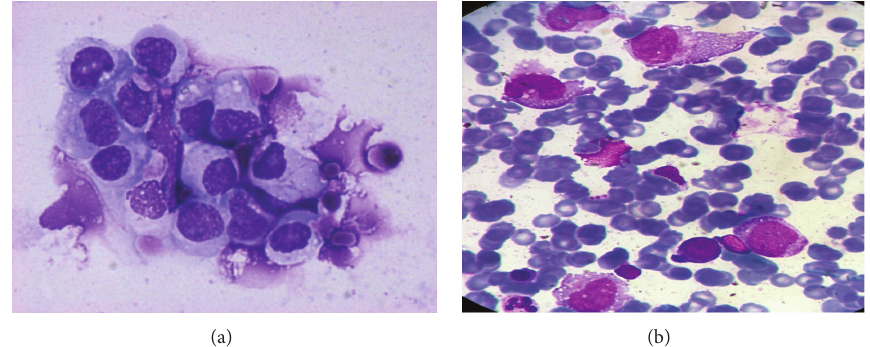
Figure 2: (a) CSF was infiltrated by immature blood cells with characteristics of monoblasts. (b) The same cells were detected in the bone marrow, confirming the diagnosis of AML relapse in bone marrow and